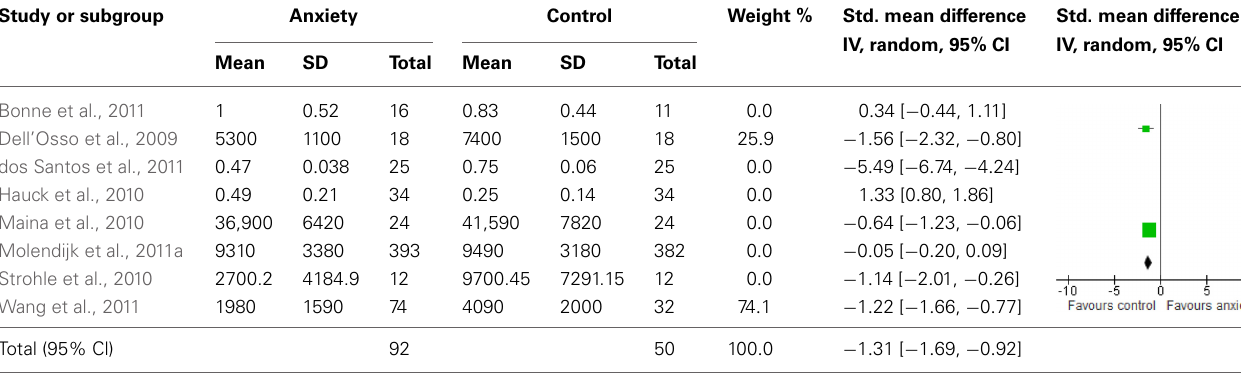
Table 5 | Sensitivity analysis: studies using plasma. Study or subgroup Anxiety Control